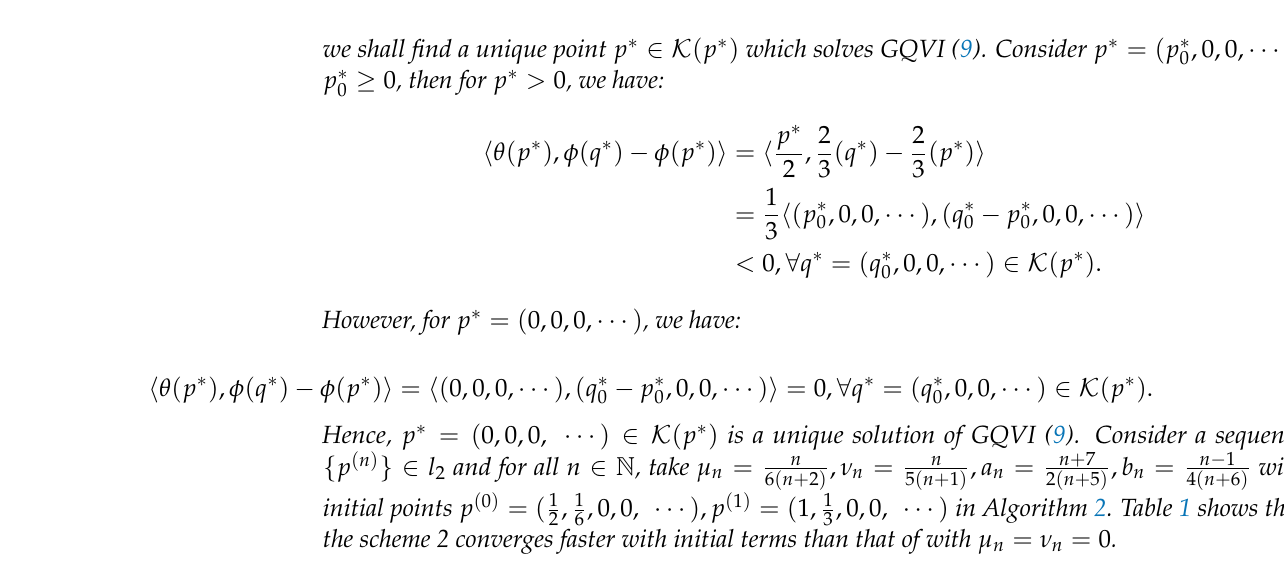
Table 1. Numerical comparison of iterative Algorithm 2 with inertial and non-inertial